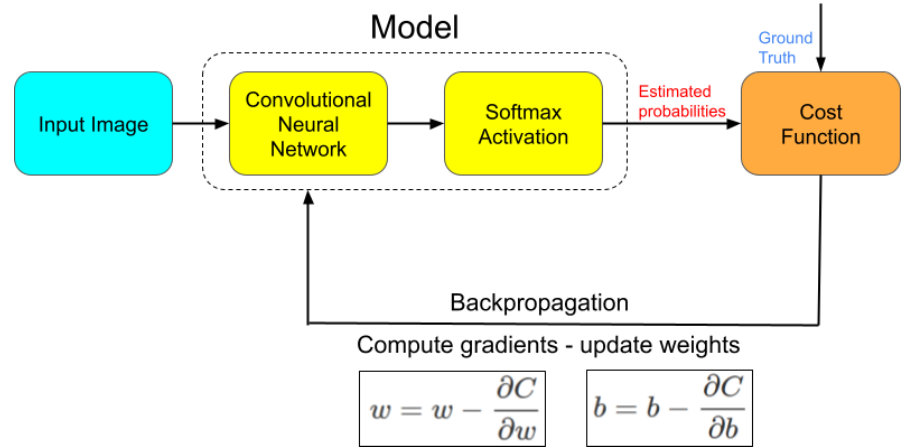
Figure A1. Schematic representation of the model training approach. C is the cost that needs to be optimized, w refers to the weights of a neuron, and b is the bias. The final layer of the CNN is cast to probability space using a softmax activation function, and the estimated probability at the end is compared with the true probability (that of the true COT) using a cost function which computes a cost. The cost or error is then back-propagated through the network backwards during which the weights and biases are updated. This process is repeated for different batches of images until the loss is minimized when the model is said to have